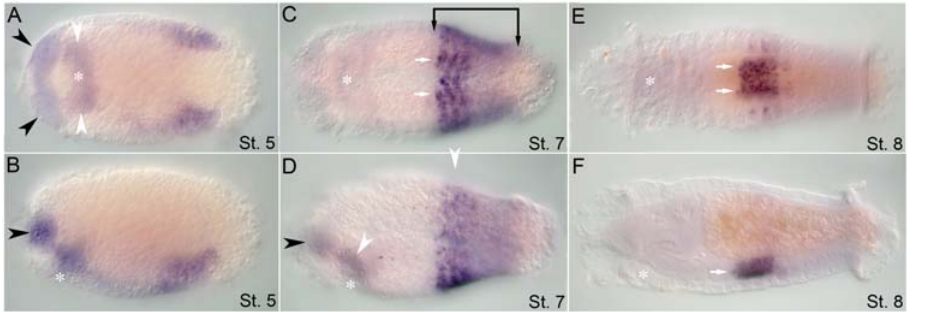
Figure 9. CapI-Antp expression during larval development. Anterior is to the left for all panels. Stages are at the bottom right of each panel. (A), (C), and (E) show ventral views; (B), (D), and (F), lateral views with ventral down. Asterisk marks the position of the mouth. (A, B) CapI-Antp is expressed in the posterior half of the mid-body in the ventrolateral ectoderm, the brain (black arrowhead), and the presumptive foregut (white arrowheads). (C, D) Expression in the VNC (white arrows) and lateral ectoderm spans segments T6 to the telotroch (bracket). Expression is consistently strongest in T6 to T8. Weak expression in brain (black arrowhead) and foregut (white arrowhead) is still detectable. (E, F) Expression is largely restricted to the VNC of thoracic segments T5 to T9 by stage 8 (white arrows).